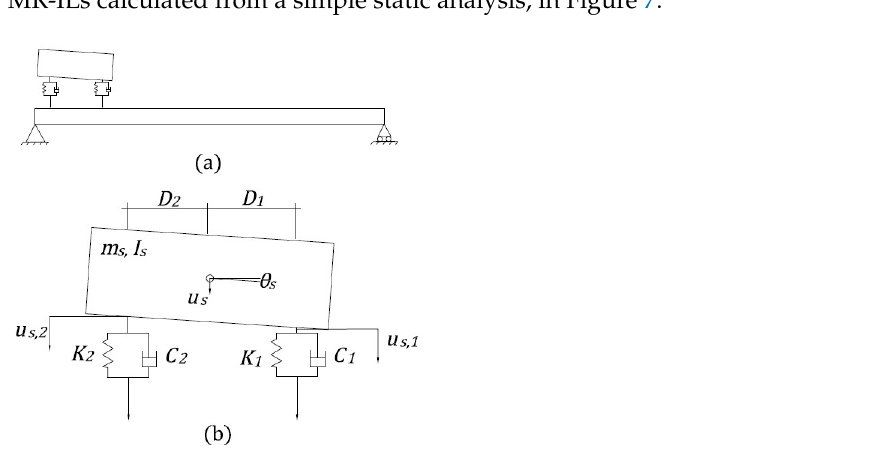
Figure 6. ( a ) 2-degree-of-freedom half-car and beam model; ( b ) 2-degree-of-freedom half-car model. Table 2. Vehicle properties used to calculate MR-IL.